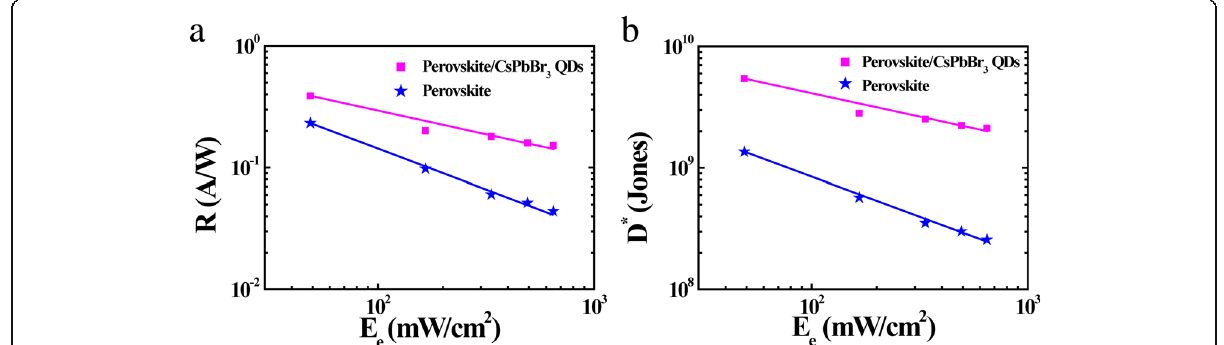
Fig. 3 Key parameters of CCPD. a R of CH 3 NH 3 PbI 3 − x Cl x perovskite devices (blue line) and perovskite decorated by CsPbBr 3 QDs devices (pink line). b D * as a function of illumination intensity E e . 405-nm continuous laser was used in the test, applied voltage V DS = V GS = 1, and irradiance E e = 0, 166, 335, 492, 648 mW/cm 2